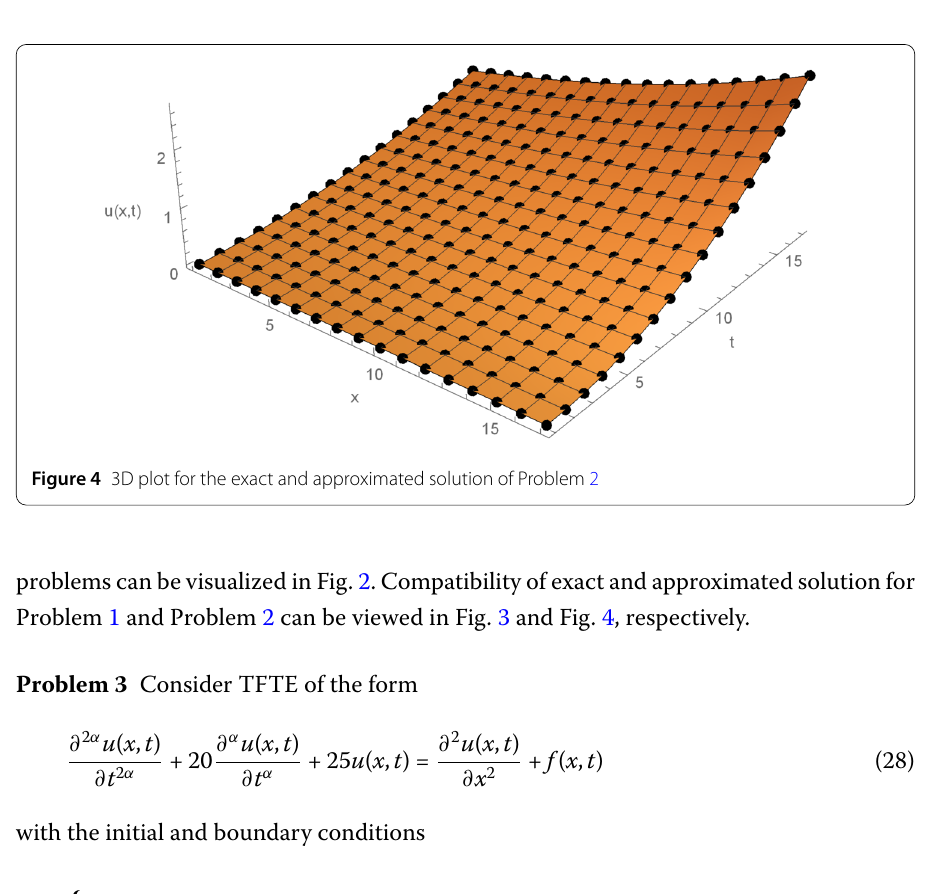
Figure 3 3D plot for the exact and approximated solution of Problem 1